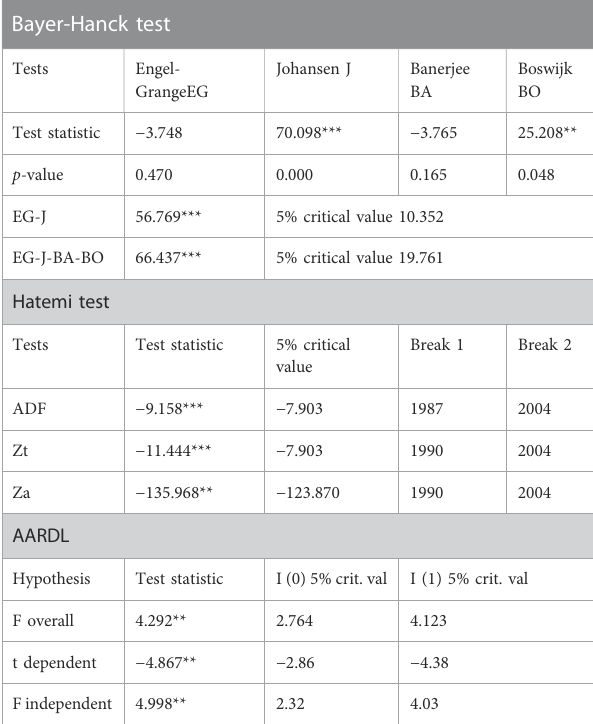
TABLE 2 Co-integration tests